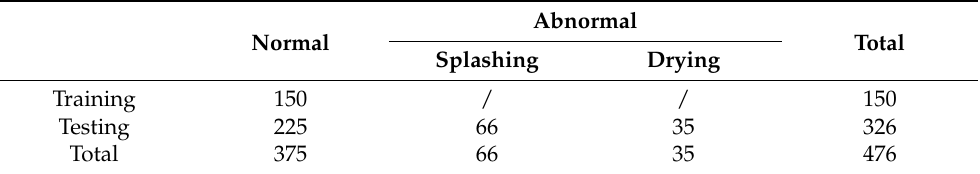
Table 1. Data partition of the steelmaking data.